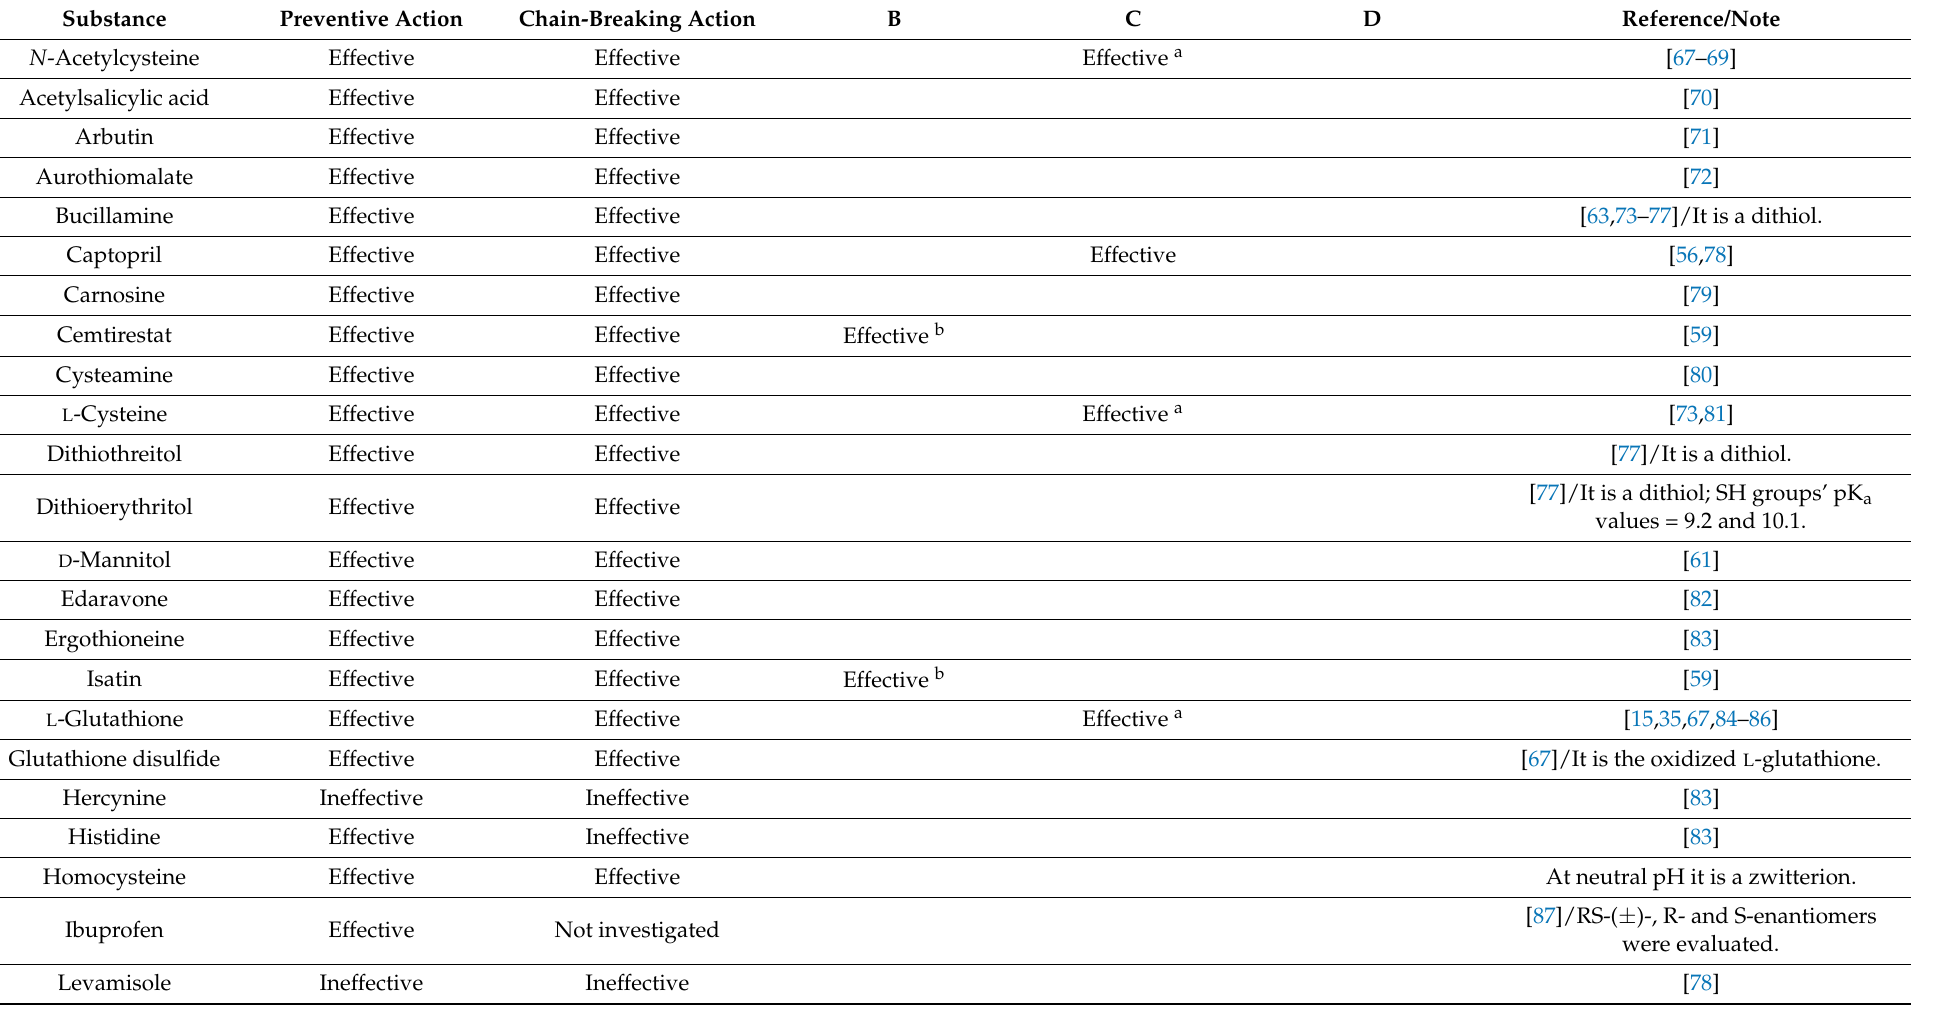
Table 1. Antioxidative profile assessment of several